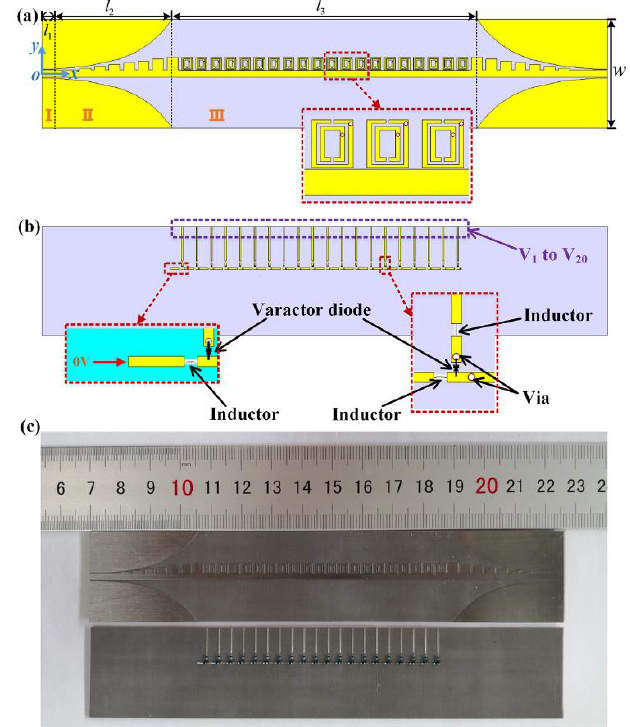
Figure 2. The schematic of the period SSPPs structure ( a ) The top view. ( b ) The bottom view. ( c ) The fabricated SSPP structure.